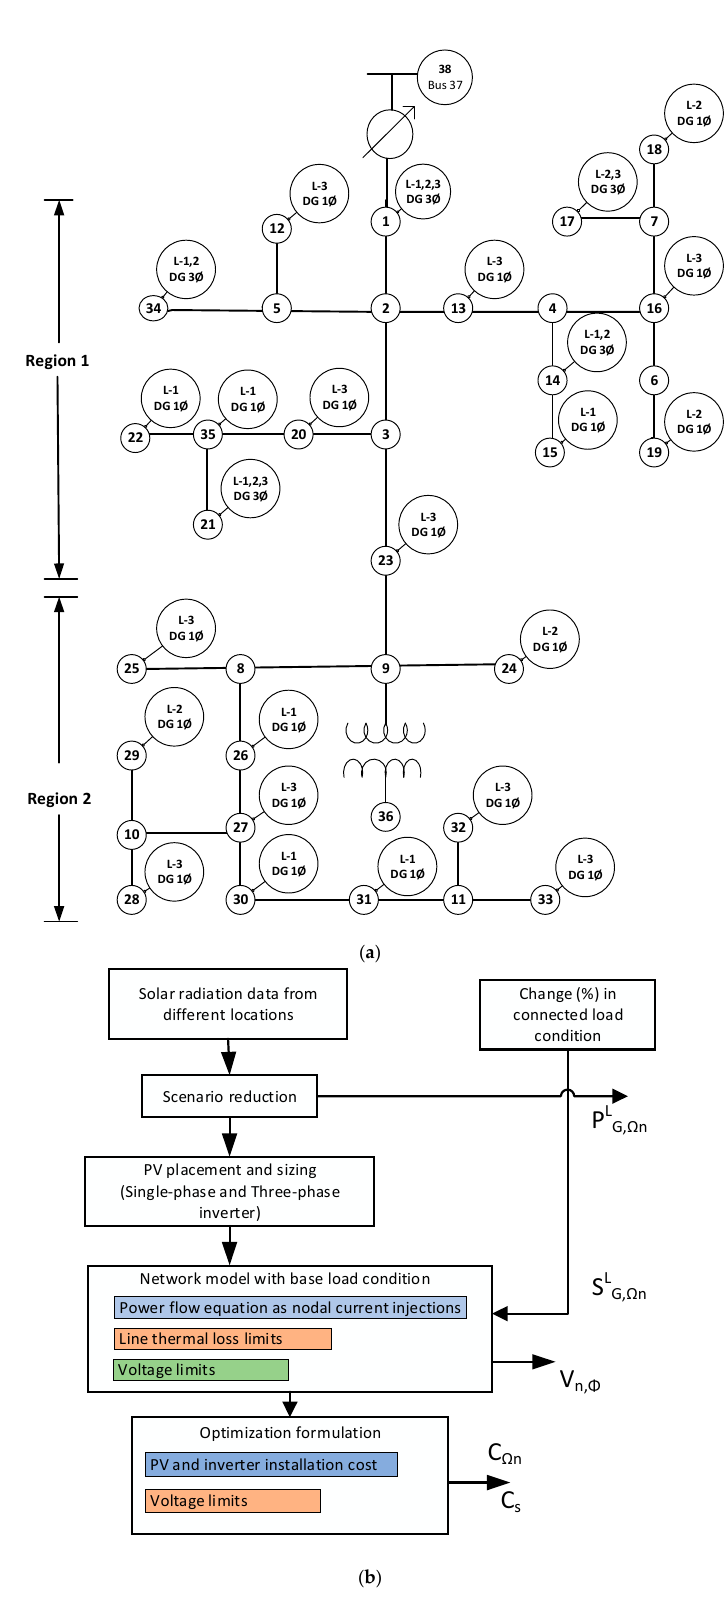
Figure 1. Overview of framework for the presented study on optimally placed and sized PVs in the distribution network. ( a ) IEEE 37 bus network showing the connected load and feasibility of PV installation. ( b ) Framework of the presented